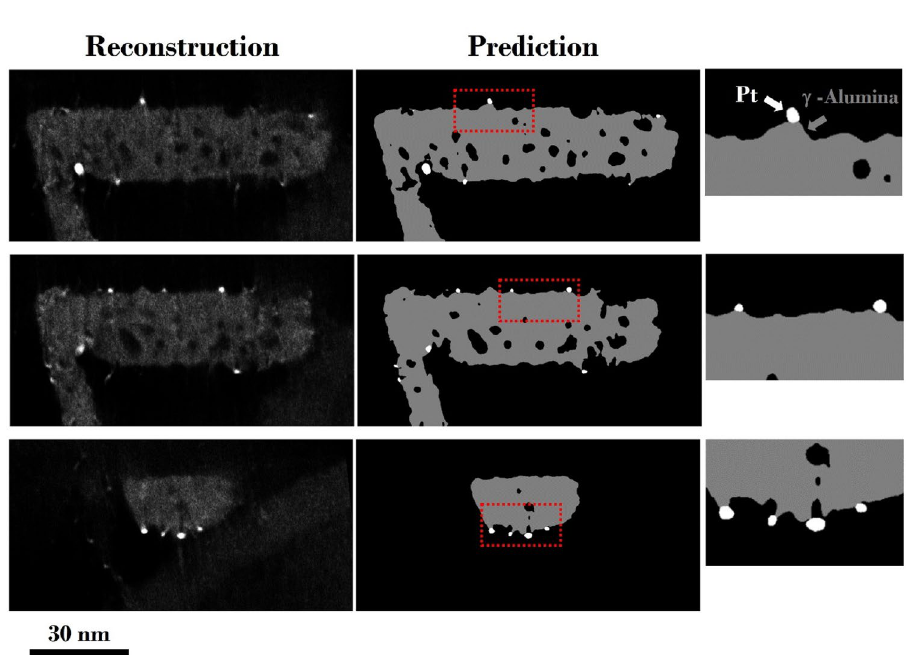
Figure 5. Comparison of the reconstruction slices (3D reconstructions) and predicted segmentations of γ-Alumina catalytic support material and Pt NPs. Reconstruction slices were extracted at various locations along the 3D